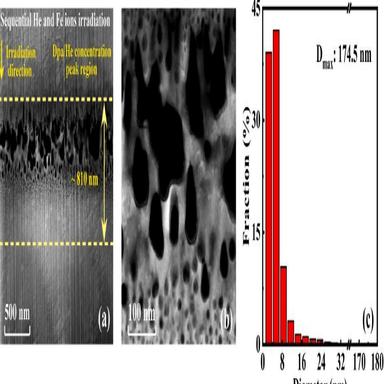
Cross-sectional TEM images of Dpa/He concentration peak region at different magnifications for Cu sample irradiated by He ions first, followed by Fe ions.